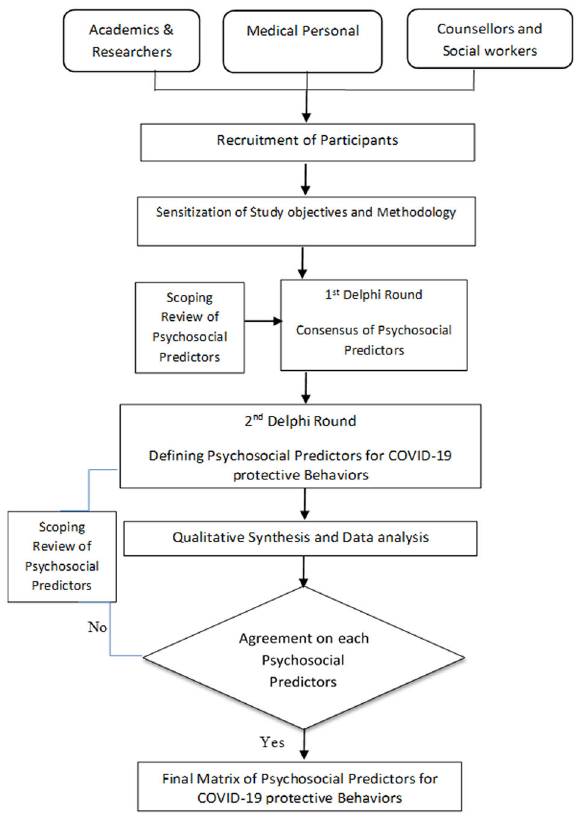
Fig. 2 Methodology in the Delphi consensus study, outlines how the Delphi method proceeded through three rounds of consultation with expert panel members in order to achieve consensus. The Delphi process comprised three rounds. In round one, the panelists were presented with 24-items questionnaire using fi ve-point Likert scale The consensus was reached when the absolute deviation was less than one point on the fi ve- point scale (i.e., ±10%). Any indicators for which consensus was not reached at the end of Round 2 were eliminated in Round 3. The survey was continued for three